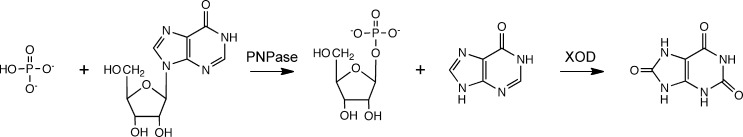
Structures of E. coli PHP and type-II inorganic PPases.A) Tertiary structure of E. coli DNA Polymerase III α subunit (PDB 2HNH). The PHP and the Polymerase domains are represented in green and blue, respectively. B,C) Detail of the entire PHP domain (B) and of the PHP β-sheet (C). The antiparallel β-strand is represented in C with green colour. D,E) Active sites of the type-II inorganic PPase from Bacillus subtilis (D, PDB 1WPM) and Streptococcus gordonii (E, PDB 1K20). The proposed active site of E. coli PHP is shown in panel F. The following amino acids are shown as sticks: H9, D13, D15, D75, H98, and D149 (D, Bacillus subtilis); H9, D13, D15, D77, H99, and D151 (E, Streptococcus gordonii); H12, D19, D43, D69, H83, and D201 (F, Escherichia coli PHP).